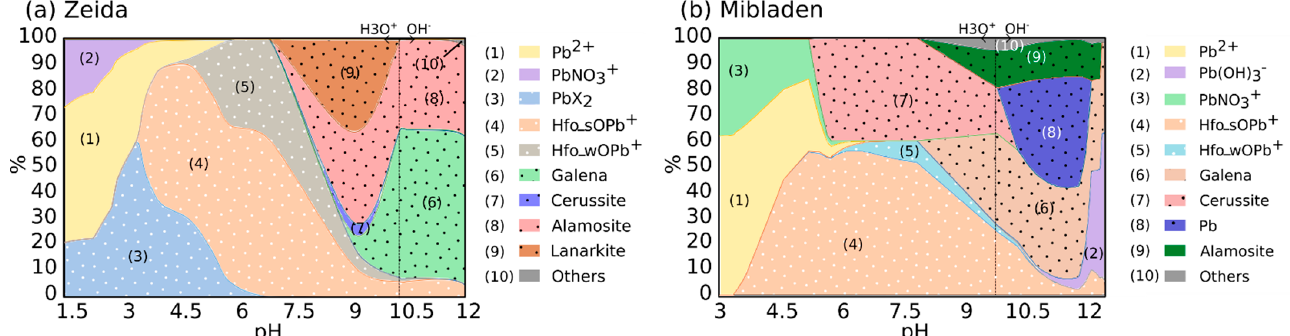
Figure 5. Speciation of lead, as a function of pH, for Zeida ( a ) and Mibladen tail ( b ) mining waste, obtained using the geochemical model (black dots: crystalline phases, white dots: surfaces, plain: in solution). Note that the range of the x -axis corresponds to the range of pH obtained for the same ANC–BNC tests with the same amounts of acidity and alkalinity. Consequently, the pH ranges differ between the two cases.